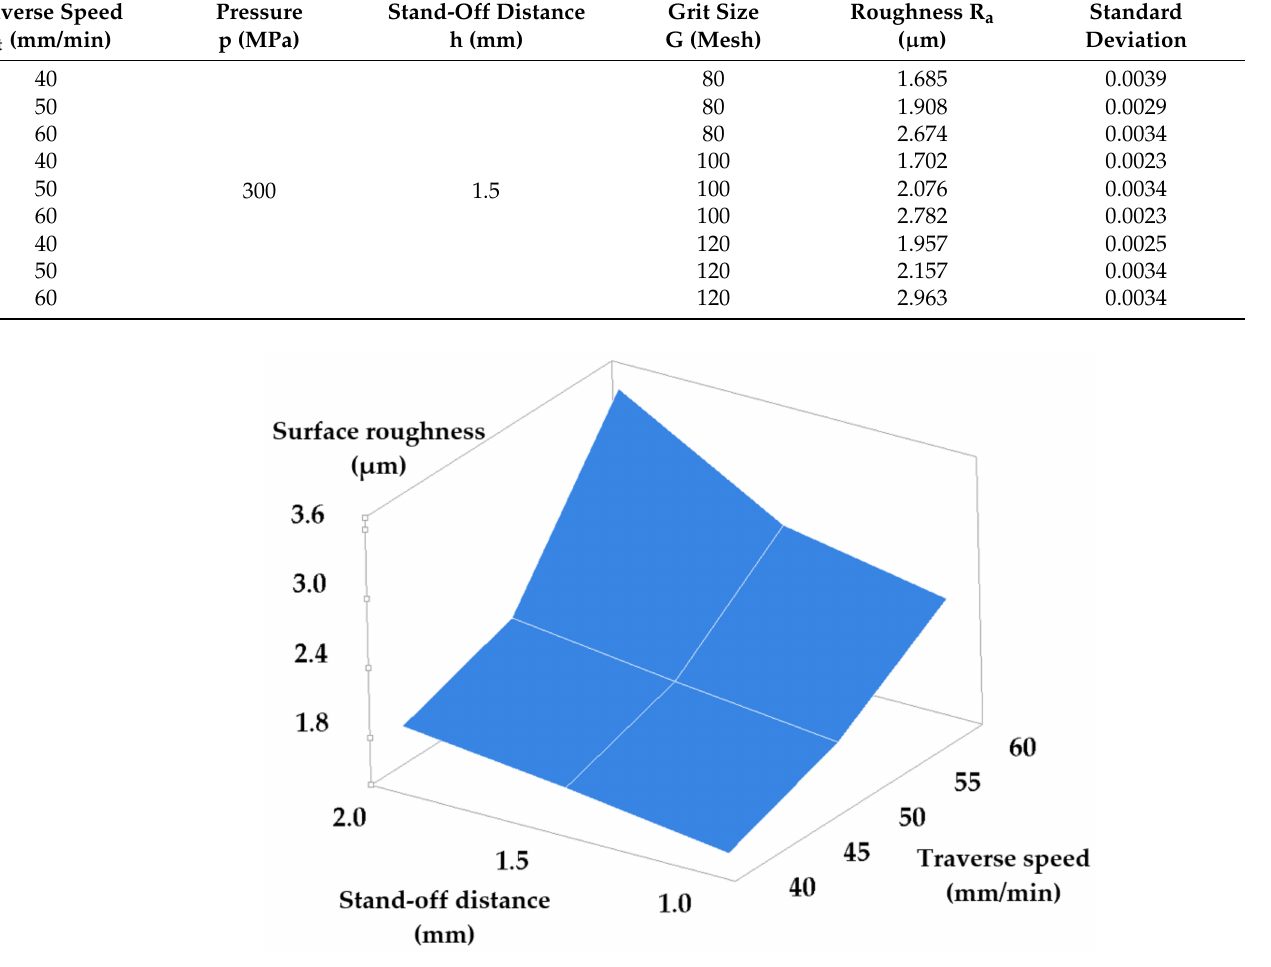
Figure 5. Roughness versus stand-off distance and traverse speed set-point modification.